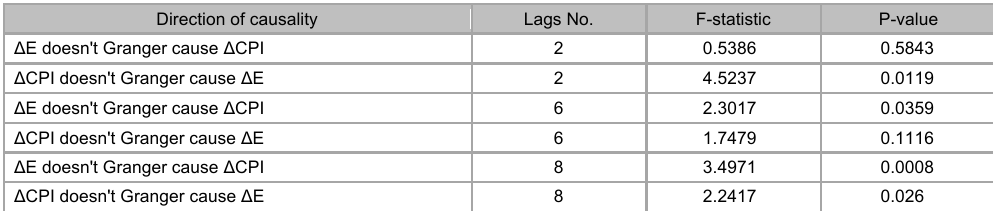
Results of Granger-causality test between exchange rate and CPI inflation Direction of causality Lags